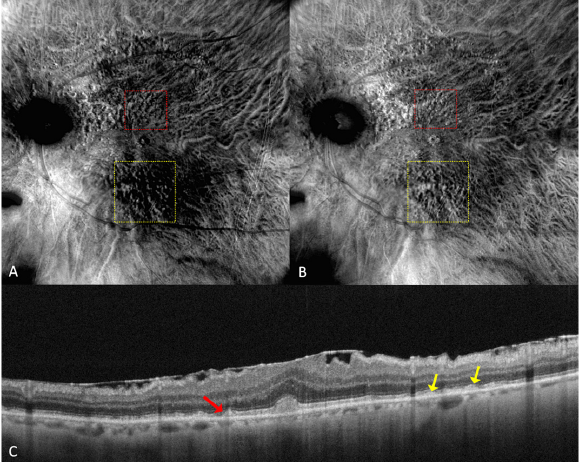
Figure 4. ( A ) On the retromode image DR dot SDDs are round, hypore fl ective lesions, and ribbon SDDs are di ffi cult to see. ( B ) Retromode image DL shows each dot SDD as “hypore fl ective core” with a “hyperre fl ective halo” [24], while the ribbon SDDs tend to have a reticular structure. ( C ) SD-OCT shows dot SDD (red arrow), ribbon SDDs (yellow arrows), and also a hyper-re fl ective layer on the retinal surface.